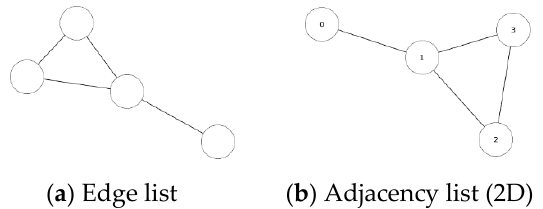
Figure 7. Schematic representations of edge ( left side ) and adjacency ( right side ) lists. ( a ) Edge list (2D), ((0, 1), (1, 2), (1, 3), (2, 3)); ( b ) Adjacency list (2D), 0 = (0, 1), 1 = (1, 2), 2 = (1, 3), 3 = (2,